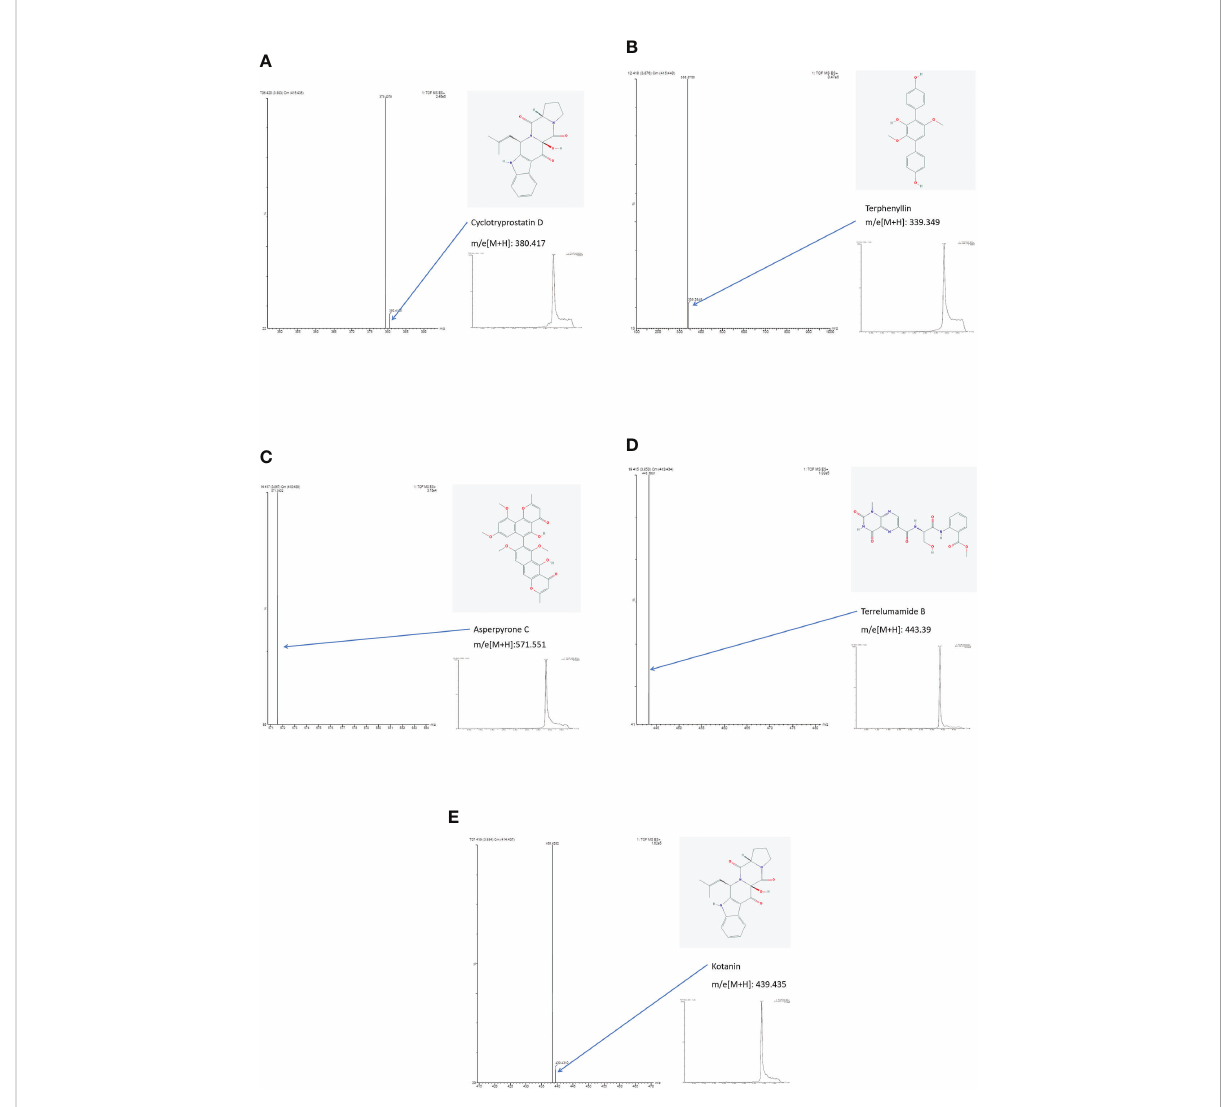
FIGURE 3 Results of ion chromatography and mass spectrometry: (A) Cyclotryprostatin D; (B) Terphenyllin; (C) Asperpyrone C; (D) Terrelumamide B; (E)